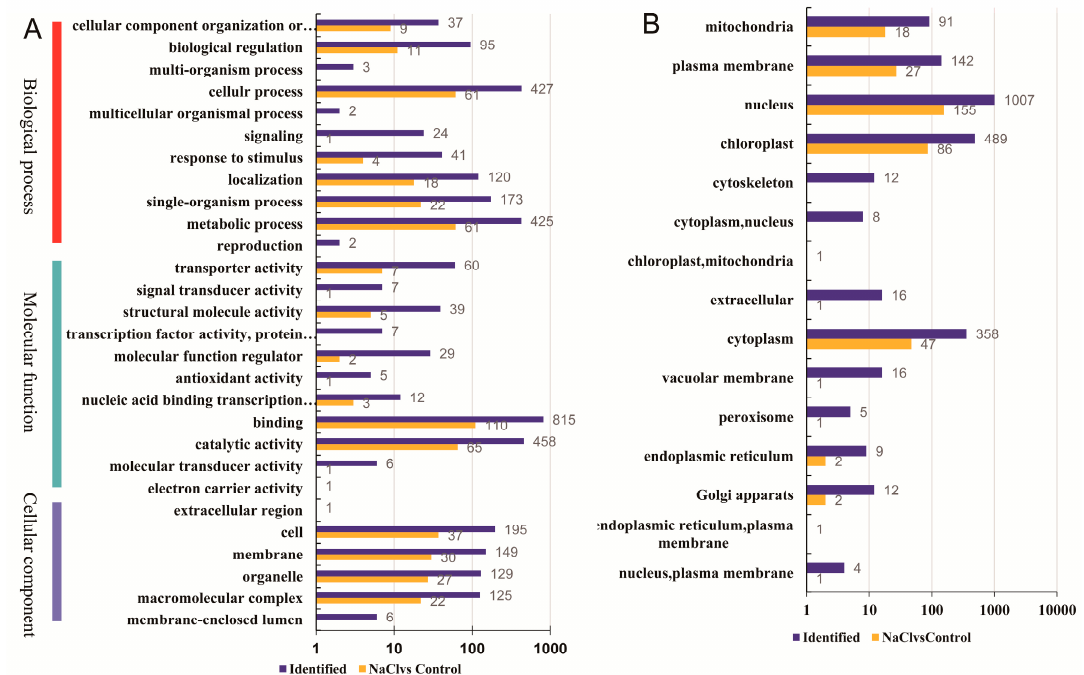
Figure 2. Classification of all identified phosphorylated proteins and differentially phosphorylated proteins (DPPs). ( A ) Gene Ontology (GO) analysis of all identified phosphorylated proteins and DPPs. All proteins were classified by GO terms based on three categories: molecular function, biological process and cellular component. ( B ) Subcellular classify of phosphorylated proteins and DPPs.